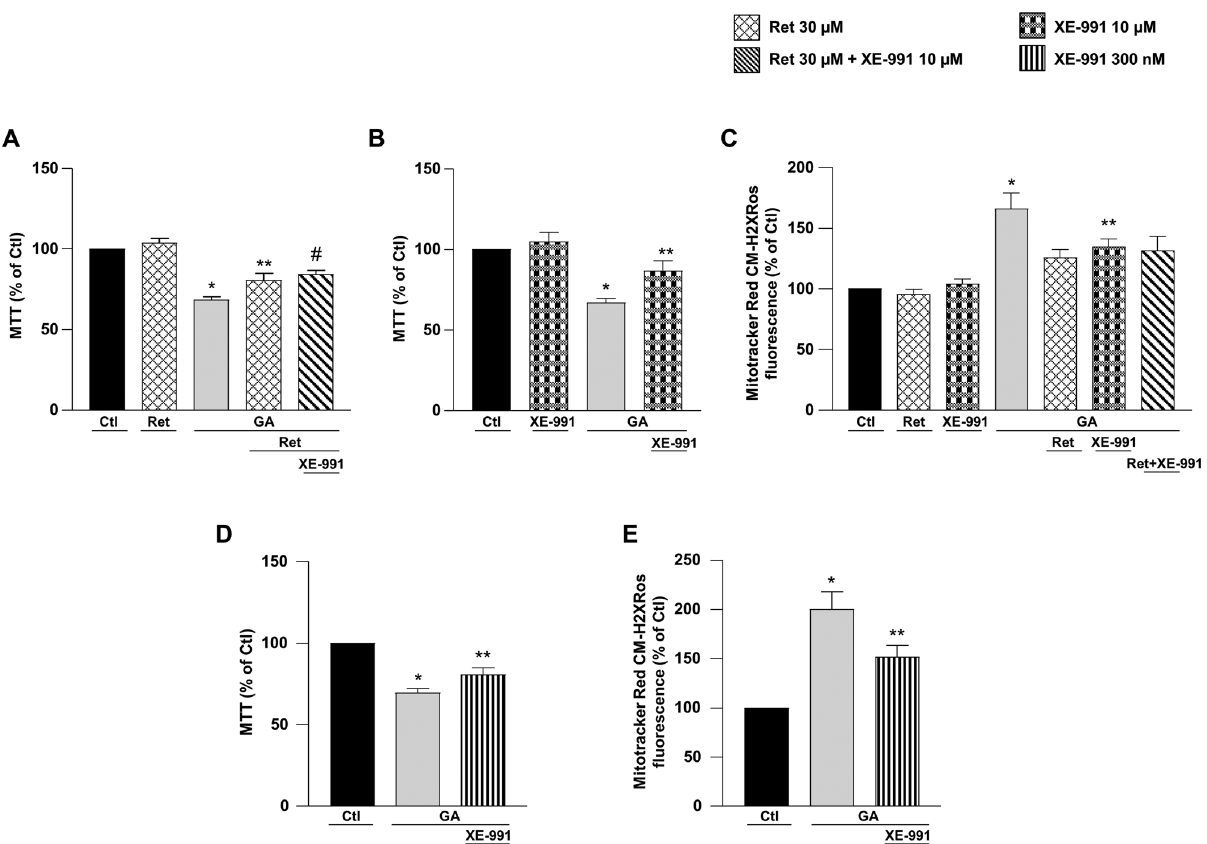
Fig. 1 The neuroprotective effect of Ret (30 µM) and XE-991 (300 nM – 10 µM) against GA-induced cell damage in RA-differentiated SH- SY5Y cells. A , B , D Effect of Ret and XE-991 on cell viability, assessed by MTT assay, and C , E mitochondrial ROS production assessed by measuring MitoTracker Red CM-H2XRos fl uorescence intensity in cells challenged with GA. Cells were pretreated with Ret (30 µM) and XE-991 (300 nM – 10 µM) for 1 h and then exposed to GA (1 mM) for 24 h (without withdrawing Ret and XE-991). In each experiment MTT reduction and the fl uorescence intensity of MitoTracker Red CM-H2XRos were expressed as control percentages. Differences among means were evaluated by one-way ANOVA followed by Dunnett ’ s post hoc test. A F (4, 35) = 32.35. Each column depicts the mean ± S.E.M. of at least four independent experiments that were performed in triplicate. *Signi fi cant versus all groups ( p < 0.0001 versus control groups, p < 0.001 versus Ret + XE-991 + GA, p < 0.01 versus Ret + GA); **signi fi cant versus control groups ( p < 0.0001) and GA ( p < 0.01); # signi fi cant versus Ctl ( p < 0.0001), Ret and GA ( p < 0.001). B F (3, 18) = 15.52. Each column depicts the mean ± S.E.M. of at least four independent experiments that were performed in triplicate. *Signi fi cant versus all groups ( p < 0.0001 versus control groups, p < 0.01 versus XE-991 + GA); **signi fi cant versus XE-991 ( p < 0.05) and GA ( p < 0.01). C F (6, 30) = 8.198. The bar plot shows the mean ± S.E.M. of fl uorescence increase evoked by ROS production. For each experimental group, the statistical analysis was performed by using the basal values derived from at least